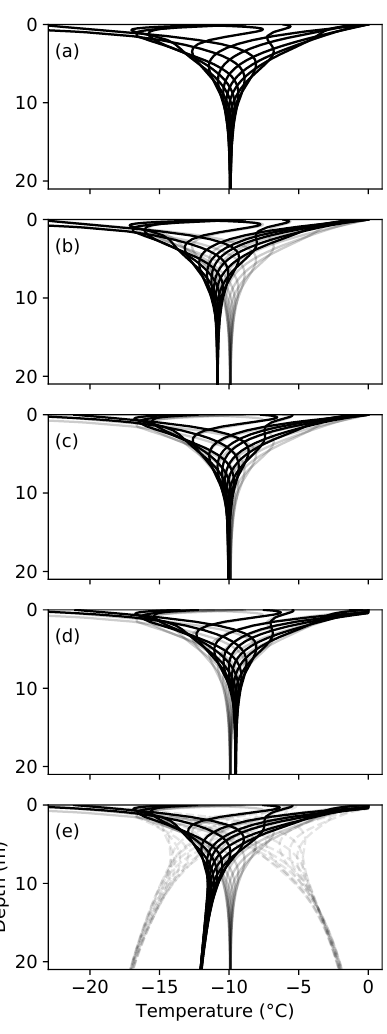
Figure 5. Model results for five separate simulations. In each case, twelve simulated temperature profiles are shown throughout the year-long period, and control results (from a ) are displayed for com- parison (gray). Differences between the simulations are analyzed quantitatively using T 0 , the convergent temperature at 21m. Pro- cesses are, from top to bottom, (a) control simulation of pure dif- fusion, (b) ablation, (c) snow insulation, (d) radiative energy in- put, and finally (e) subsurface temperature gradient. The two lim- iting cases for the subsurface temperature gradient are plotted with dashed gray lines (e)